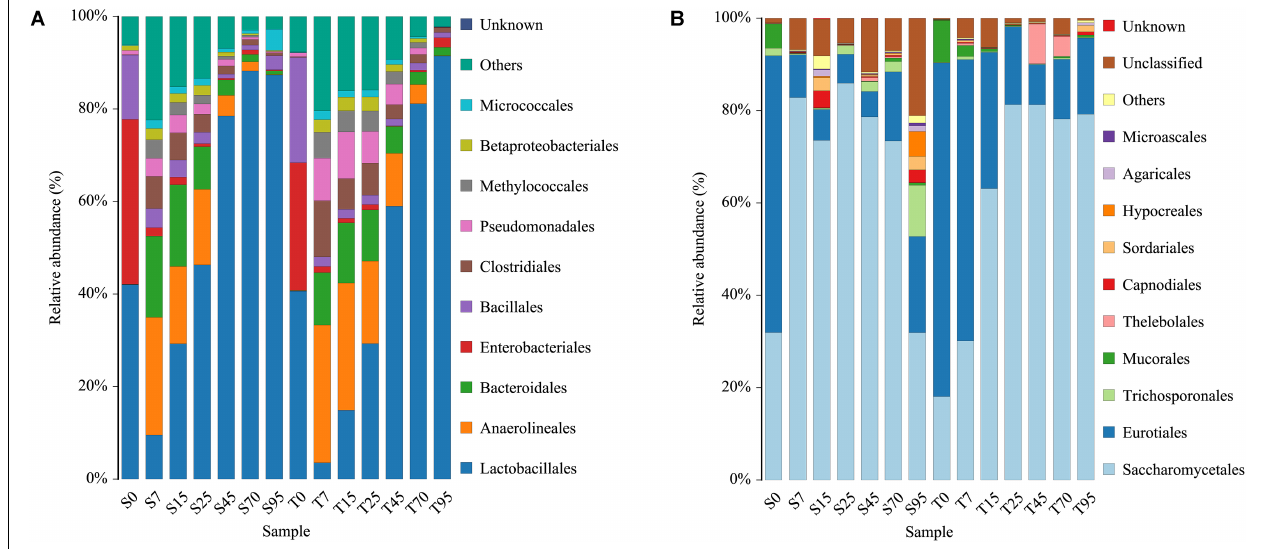
FIGURE 2 | Dynamics of relative abundances of the major bacterial (A) and fungal (B) orders during the SCSSF and TCSSF processes, as obtained by Illumina HiSeq sequencing